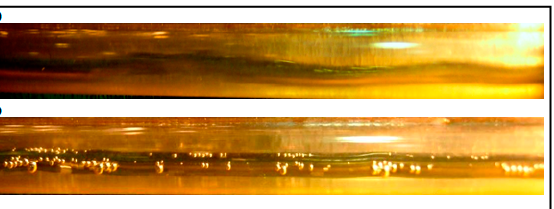
Figure 5. ( a ) Stratified Wavy flow without DRP (V sl =0.1 m/s, V sg =2.88 m/s); ( b ) Stratified Wavy flow with 40 ppm DRP.